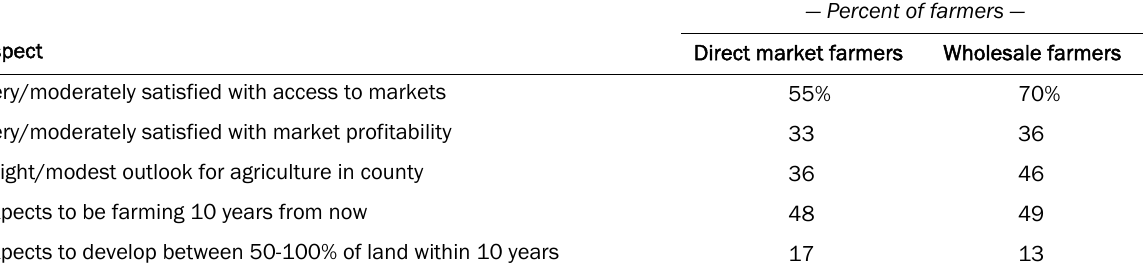
— Percent of farmers —